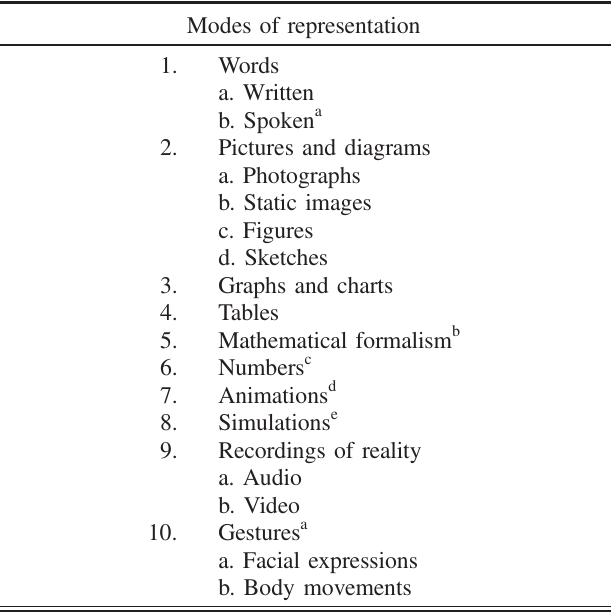
TABLE I. Modes of representation recognized in curricular